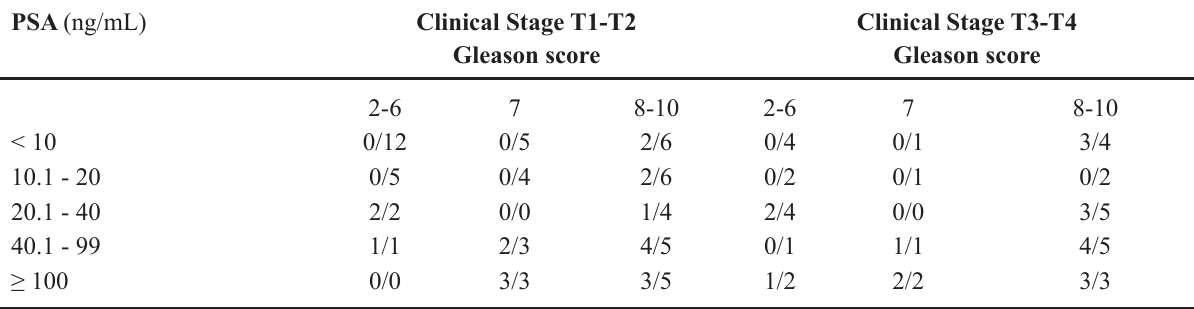
Table 2 – Number of positive bone isotope scan in relation to PSA, Gleason score and T stage prostate cancer.